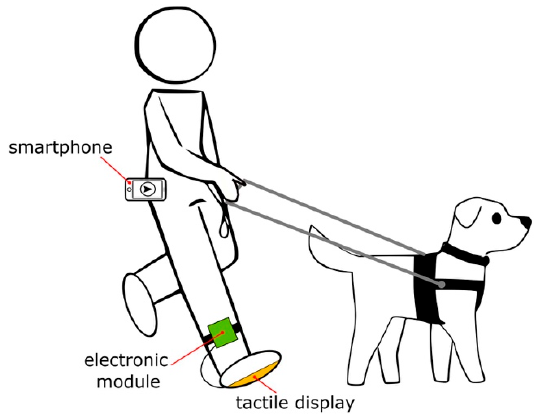
Figure 1. Conceptual representation of a user wearing the AT device. This concept encompasses the primary aids which are responsible for obstacle detection.